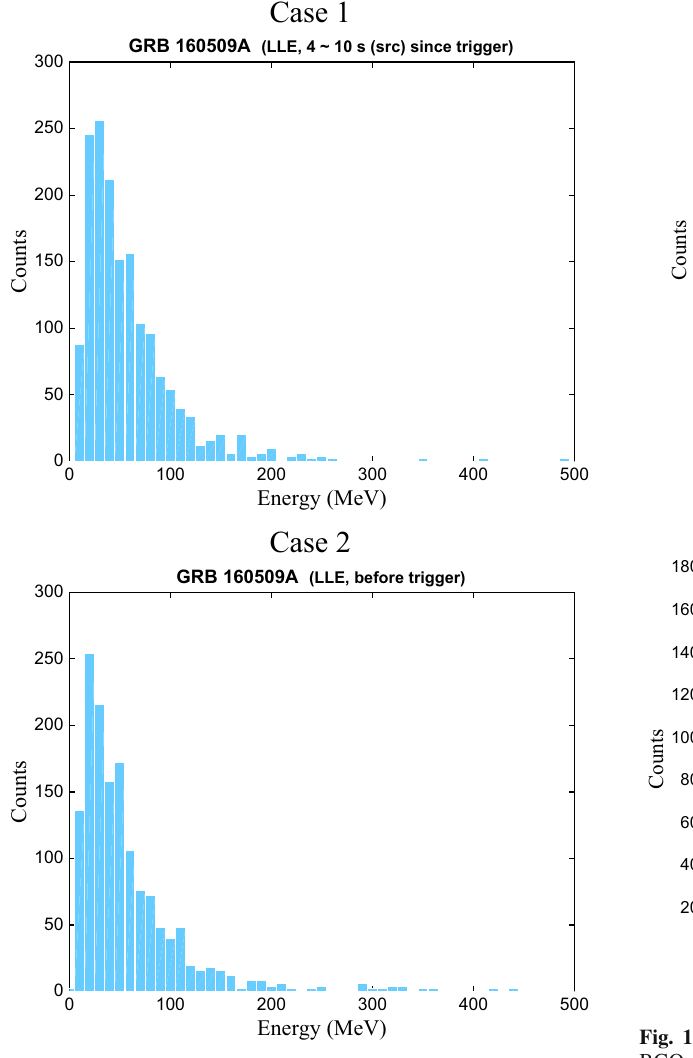
Fig. 15 The energy distribution histograms for GRB 160509A from LLE data. The upper one uses the photons within 4–15 s (with t obs /( 1 + z ) ) since trigger. The lower one uses the photons before trigger. The y - axis refers to the counts of certain rectangle. We can see that most of LLE photons are (cid:3) 100 MeV